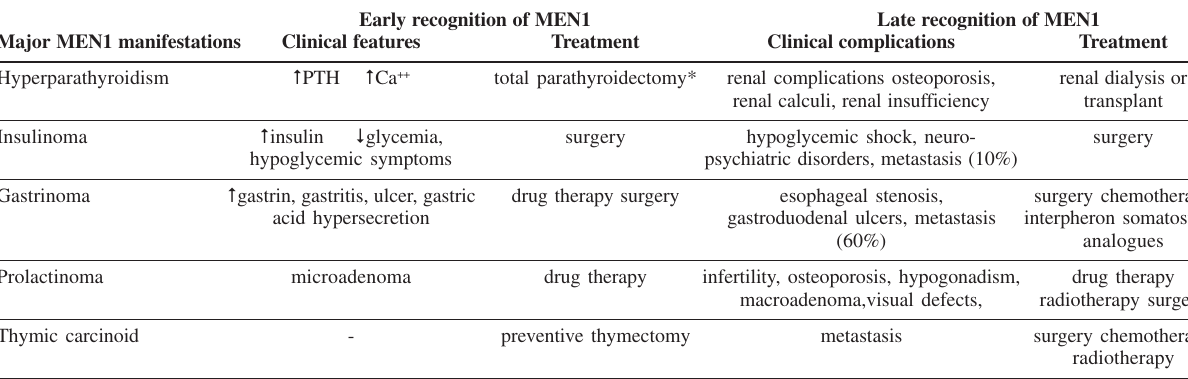
Table 4 - Usual major clinical manifestations of MEN1 at its early and late stages. Appropriate treatments for early- and late-diagnosed MEN1 patients are